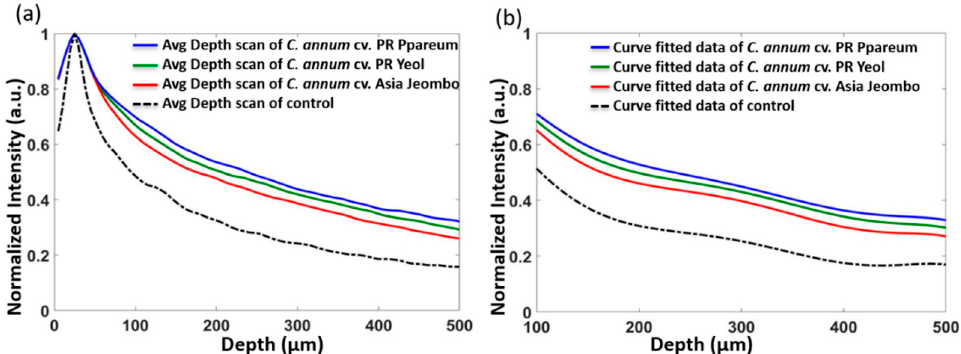
Figure 5. A Comparison of averaged depth scan profiles and the curve fitted data of seed categories. ( a ) Averaged depth scan profiles of C. annuum cv. PR Ppareum, C. annuum cv. PR Yeol, C. annuum cv. Asia Jeombo and control ( b ) Curve fitted data plotted from the depth of 100 to 500 µ m of all seed categories.